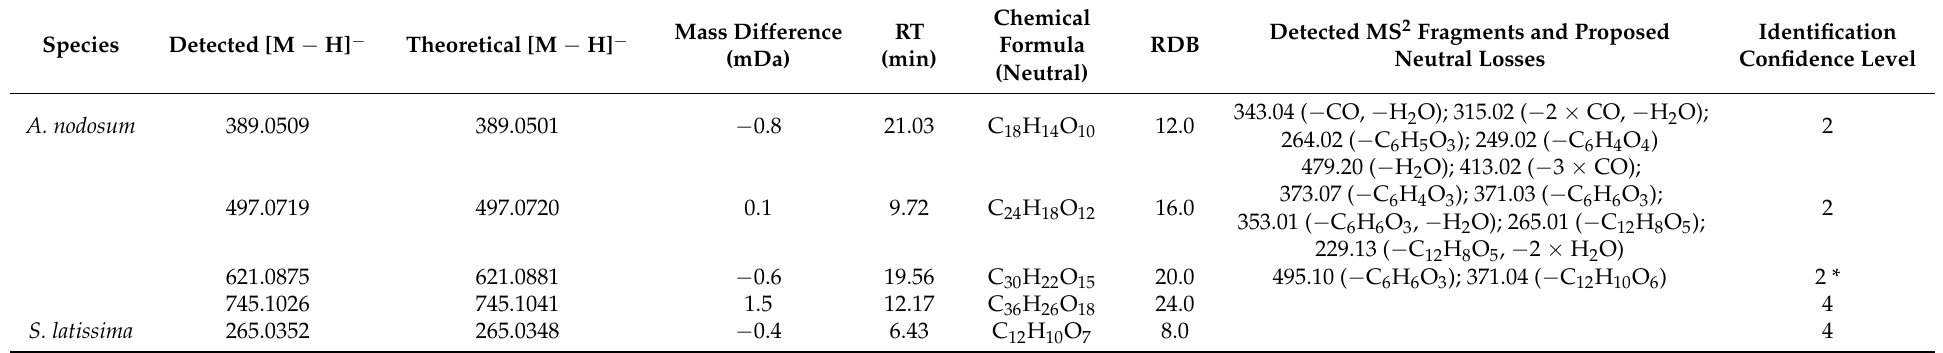
Table 1. Tentatively identified phlorotannins in A. nodosum and S. latissima in samples extracted with aqueous ethanol (80%, v / v ) with detected m / z , theoretical m / z , difference in m / z , retention time (RT), determined chemical formula, ring double bond (RDB) equivalent for neutral compounds, detected MS 2 fragments and identification level according to Schymanski et al.